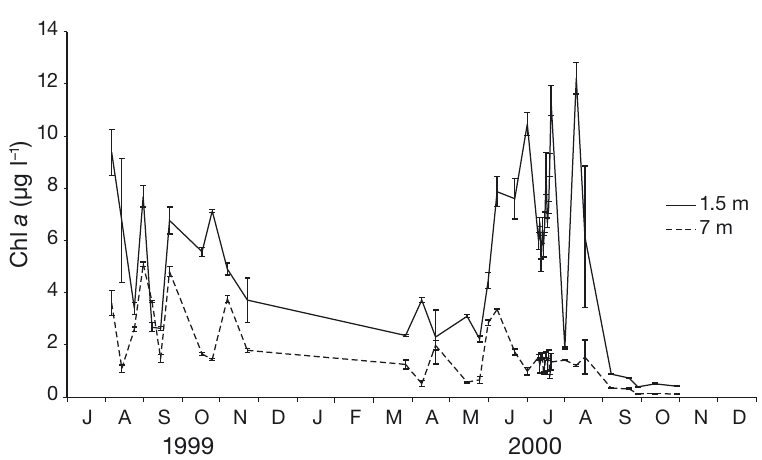
Fig. 4. Concentrations (mean ± SD) of chl a at 2 depths (1.5 and 7 m) in the center of the culture unit during a production period (Fig. 5). From the daily CTD casts, 3 separate layers within 8 m of the water column could be delineated every day (upper, middle, lower). The depth exten- sion of each layer varied between days. Concentra- tions of chl a were highest in the upper layer (5.97 ± 1.01 µg l −1 ) relative to the middle (2.85 ± 1.26 µg l −1 ) and lower layers (1.1 ± 0.39 µg l −1 ). Depletion of chl a could be detected on 3 levels and is reported as the measured relative proportion to the measured ambient (outside) conditions. On the macro- scale, comparing internal and external condi- tions of the culture unit, depletion was analyzed sep- arately for the 3 layers detected in the CTD profiles.